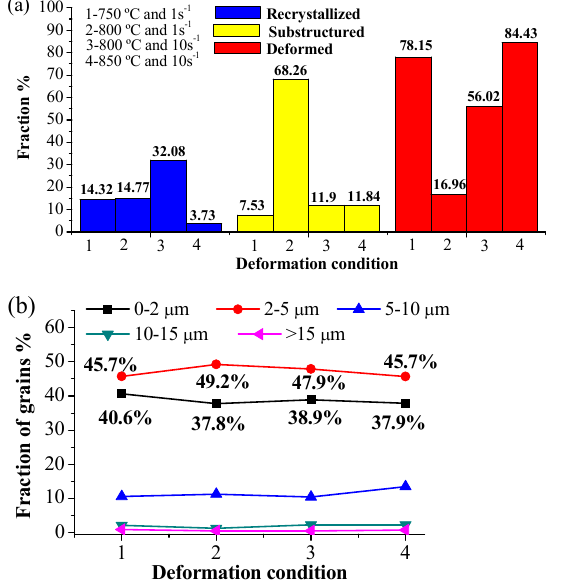
Figure 8. ( a ) The fraction of recrystallized grains, substructure and deformed grains under different deformation conditions, ( b ) Distribution of grain size under different deformation conditions .